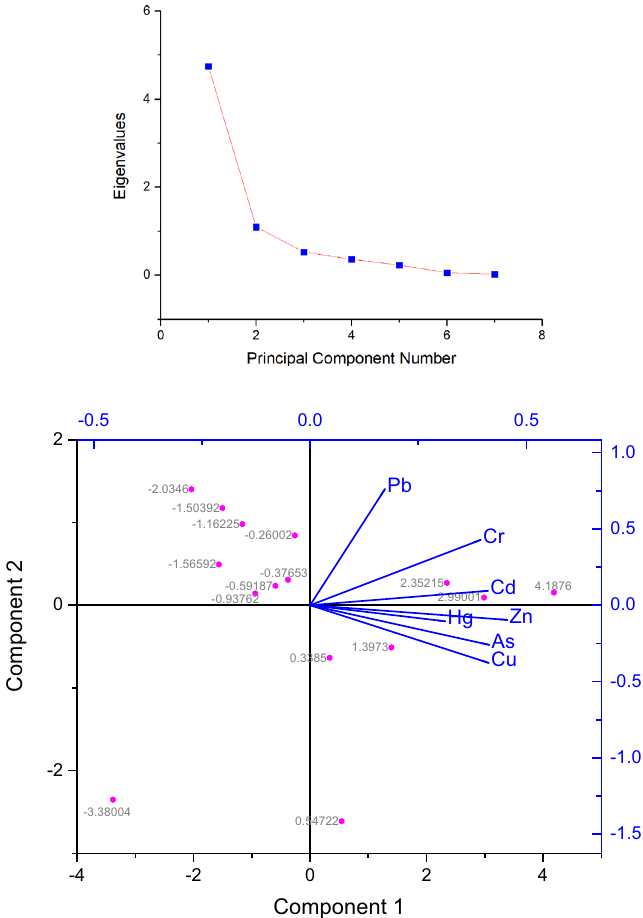
Figure 2. Scree plot and principal component analysis (PCA) loadings plot of seven heavy metals in organism’s